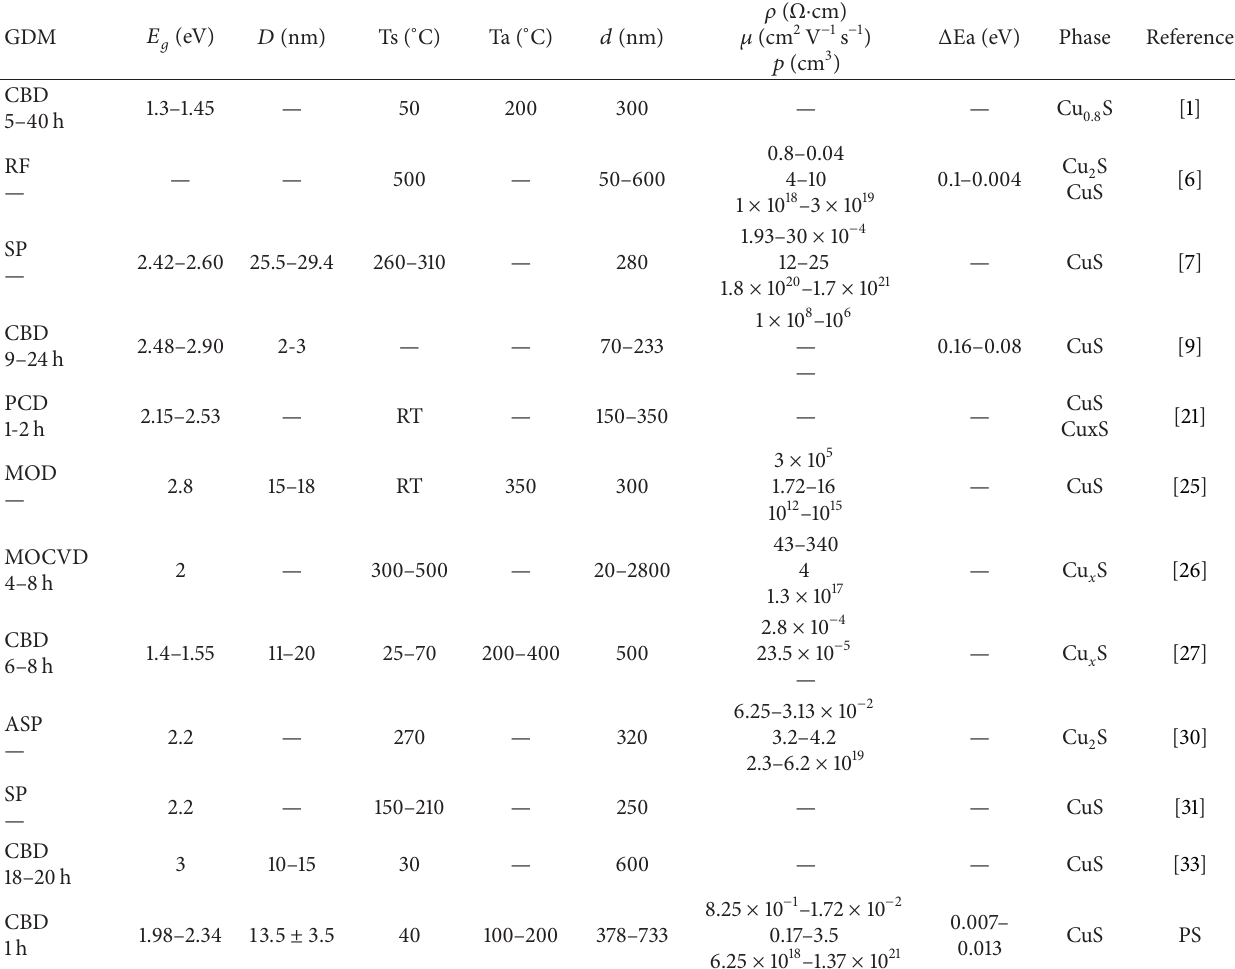
S films reported in the x